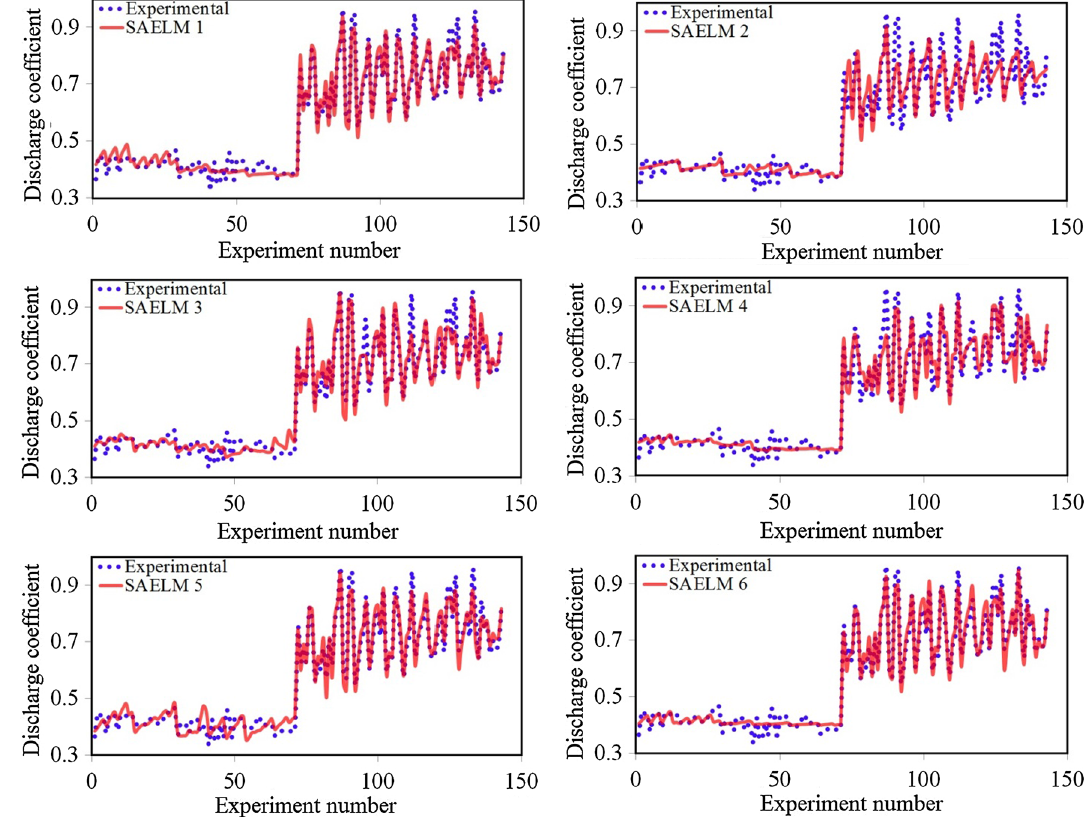
Fig. 8 Comparison of simulated and experimental discharge coefficients for different SAELM